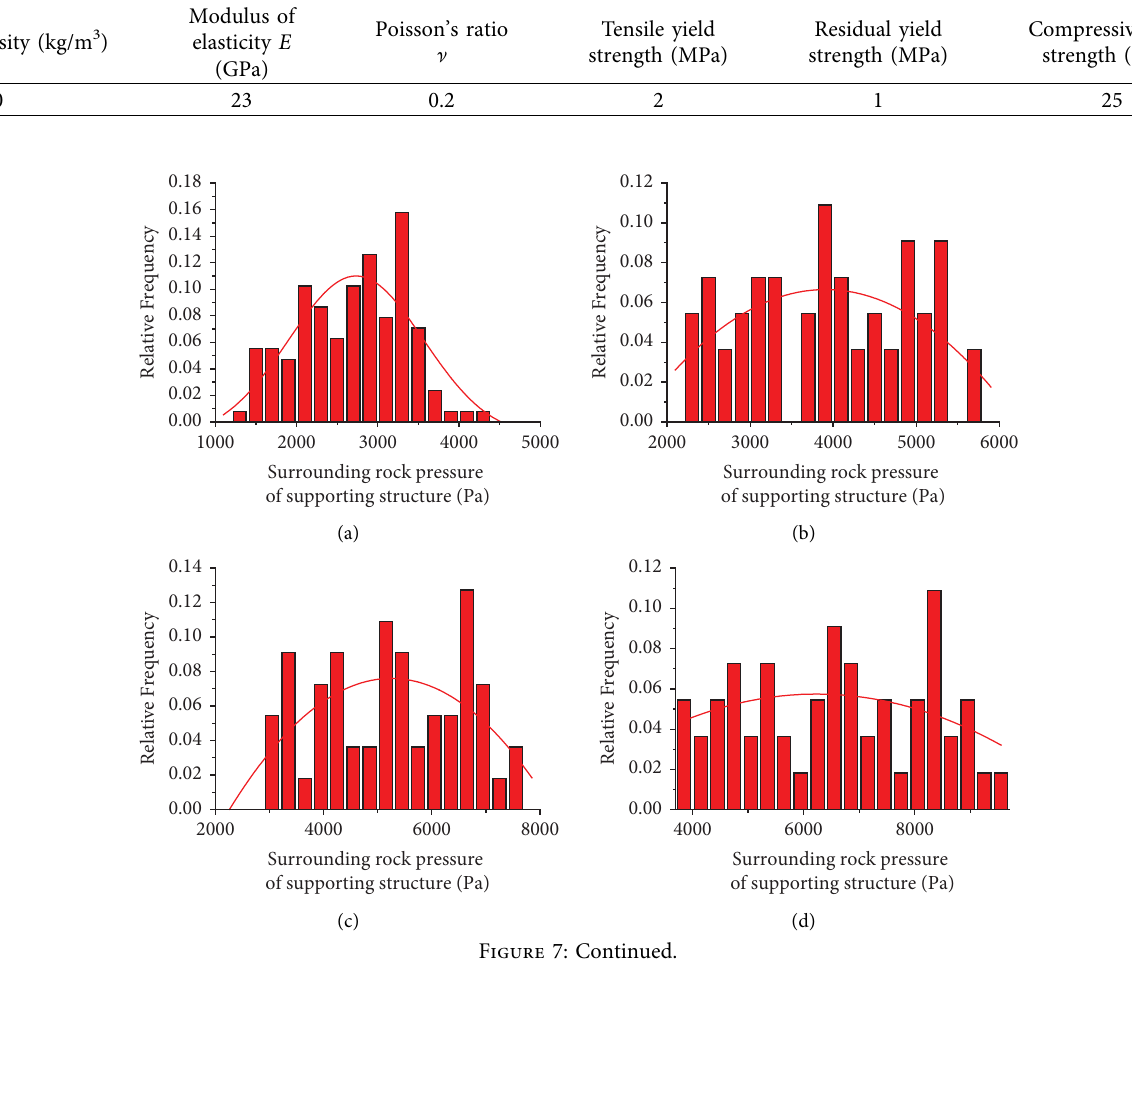
Figure 6: Process of excavation by sections: (a) excavation step 1 and support, (b) excavation step 2 and support, (c) excavation step 3 and support, (d) excavation step 4 and support, and (e) remove temporary support. Table 4: Physical and mechanical parameters of